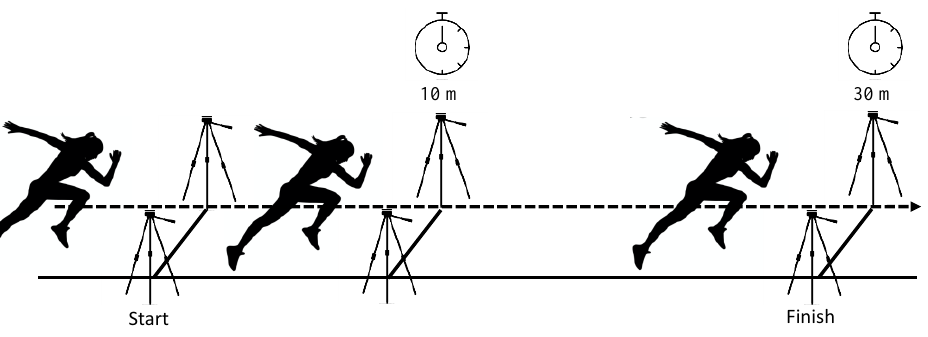
Figure 2: Acceleration evaluations at 10 m and velocity at 30 m.